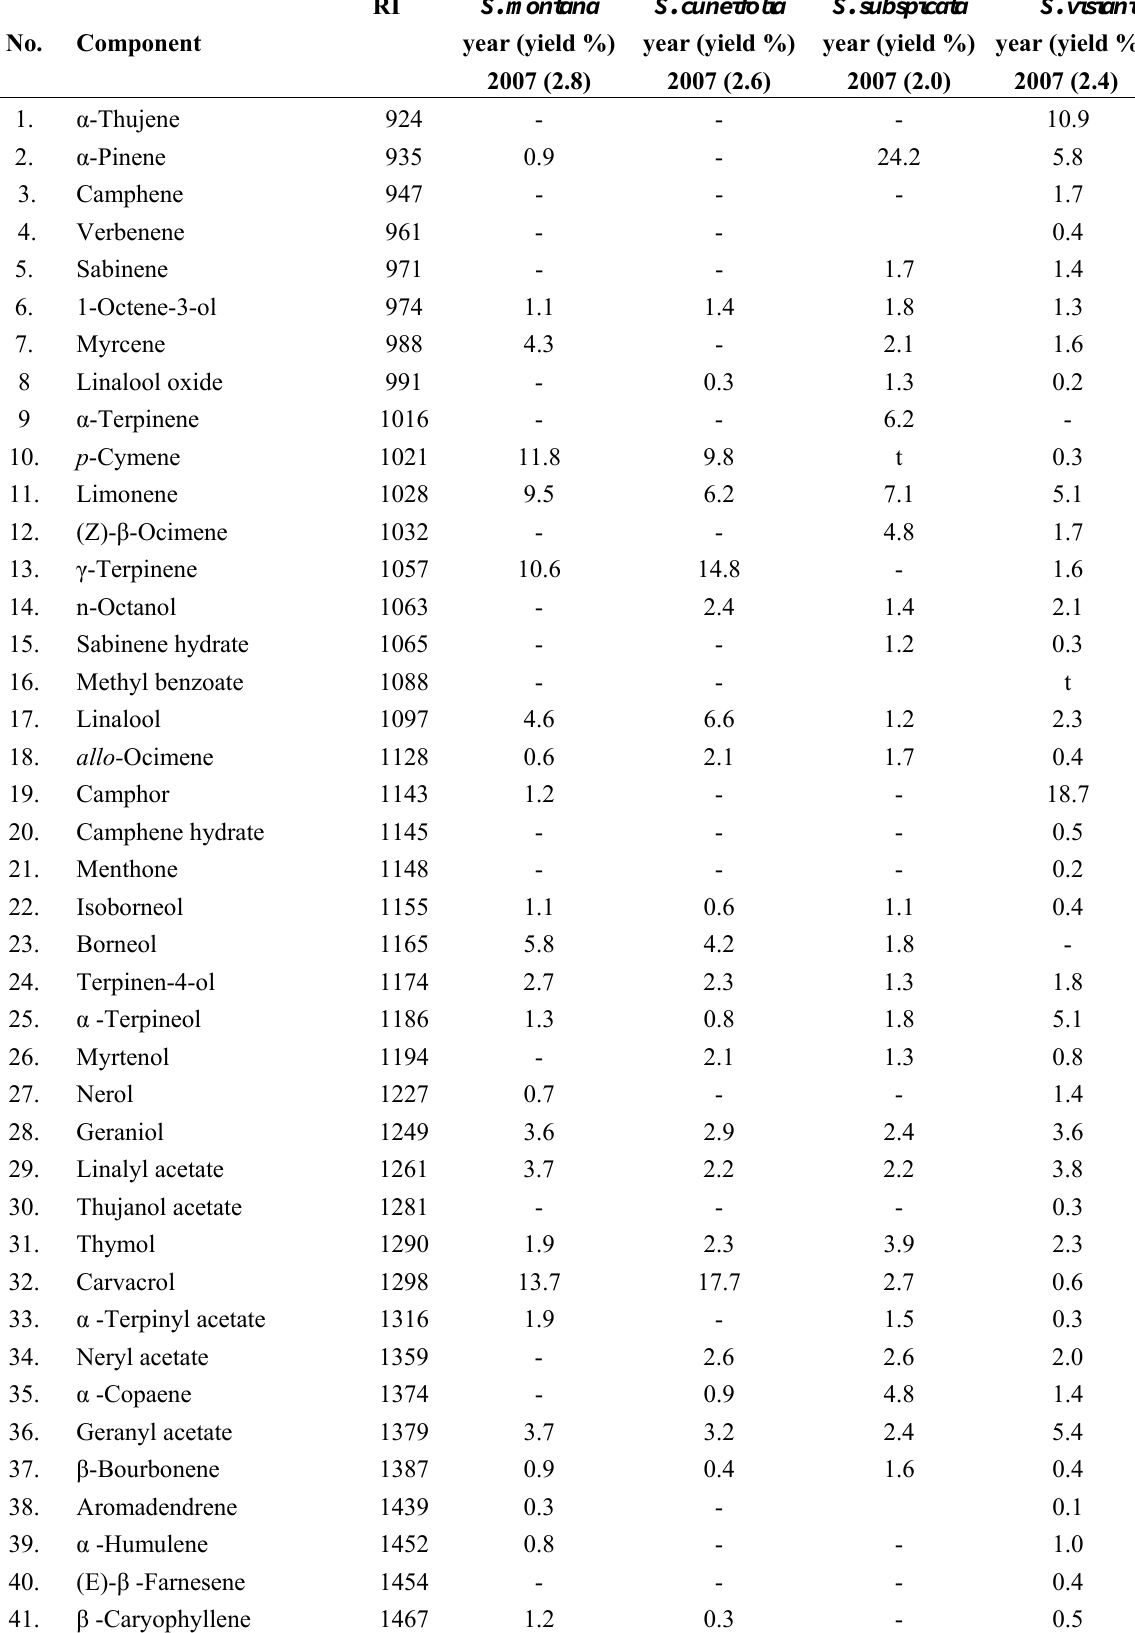
Table 1. Phytochemical composition (%) of essential oils of Satureja montana , S. cuneifolia , S. subspicata and S.